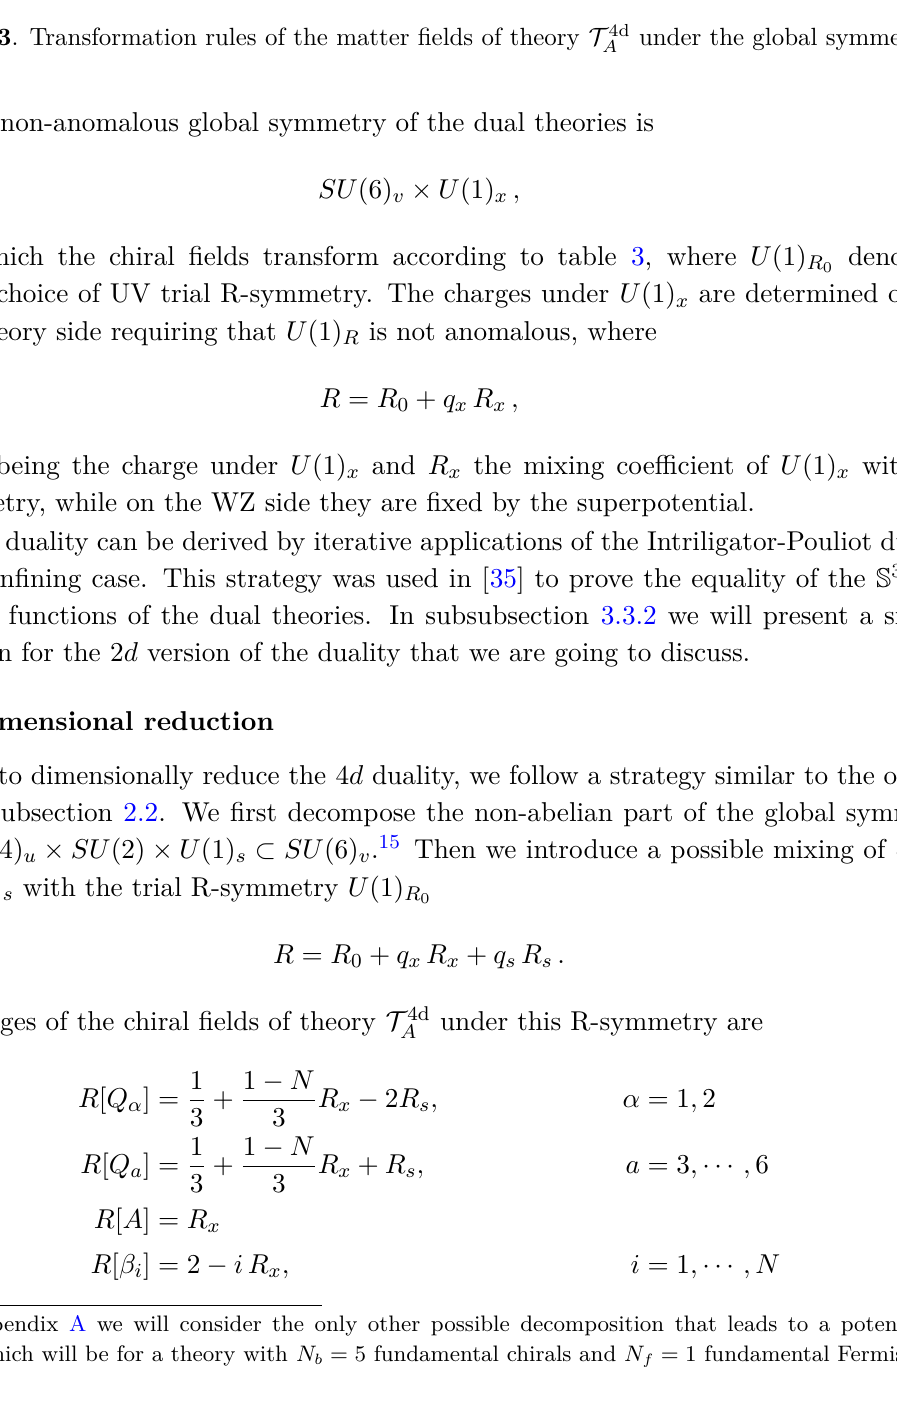
Table 3 . Transformation rules of the matter fields of theory T 4d